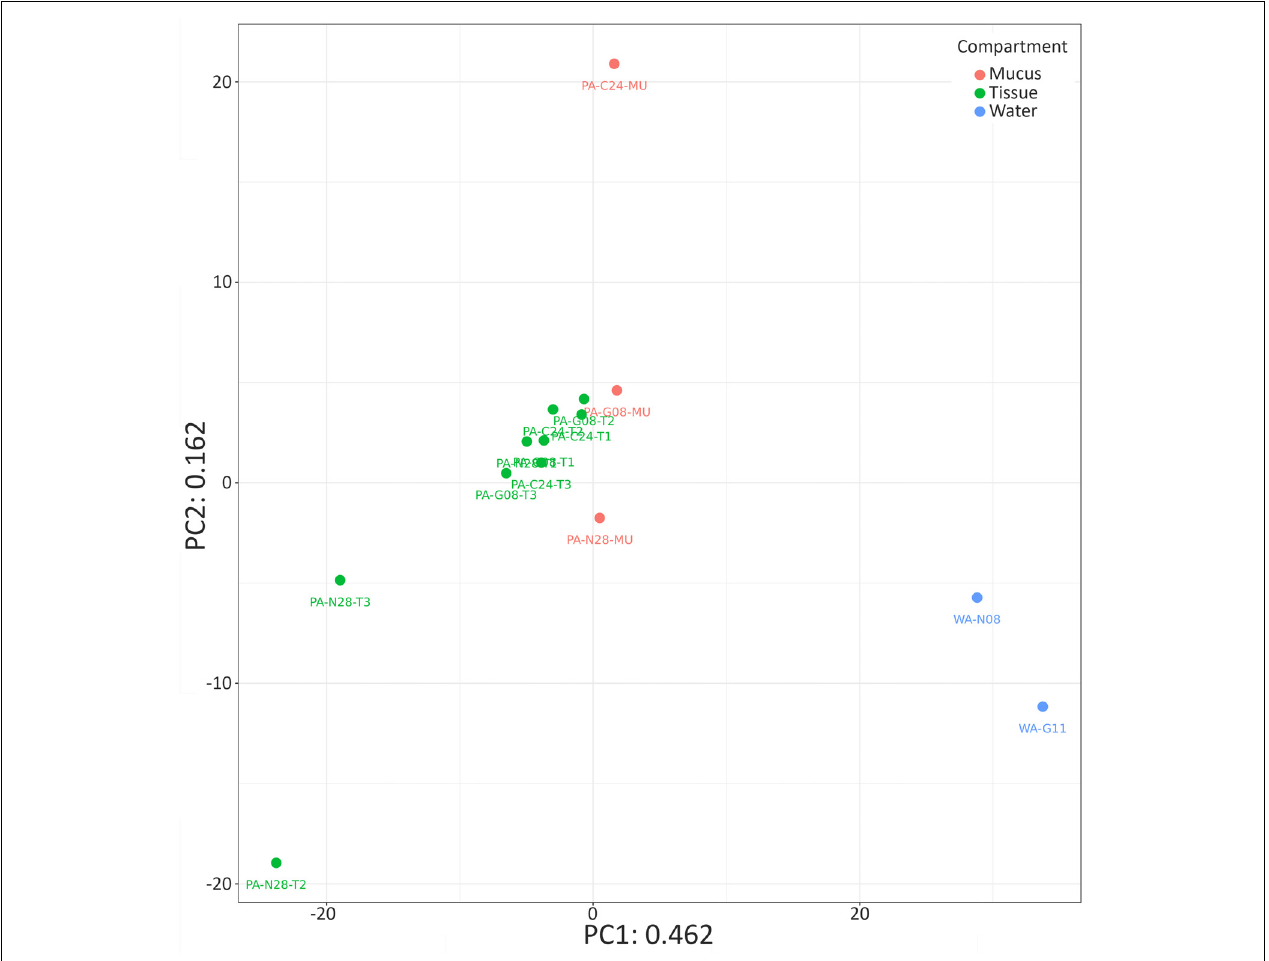
FIGURE 2 | Bacterial community similarity for Paragorgia arborea and reference seawater samples. Principal component analysis (PCA) ordination of bacterial communities in P. arborea (tissue samples in green and mucus samples in orange) and seawater samples (blue), developed from a singular value decomposition of centered log-ratio (clr)-transformed compositional data. Sample names as in Table 1